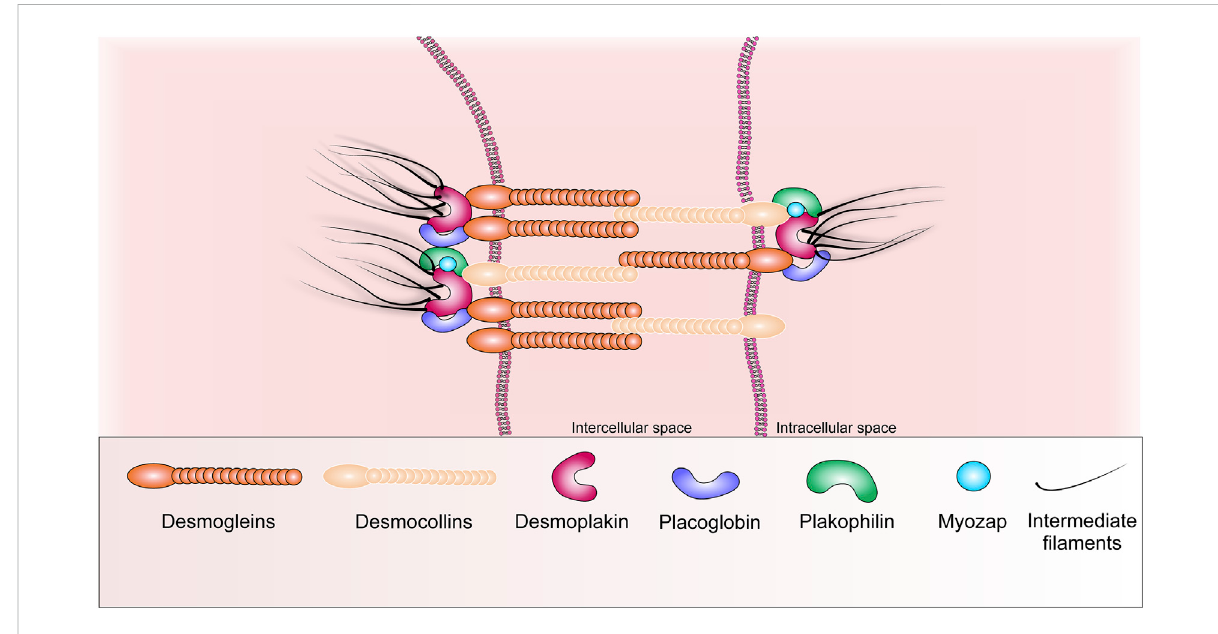
FIGURE 2 Schematic representation of the basic structural components of